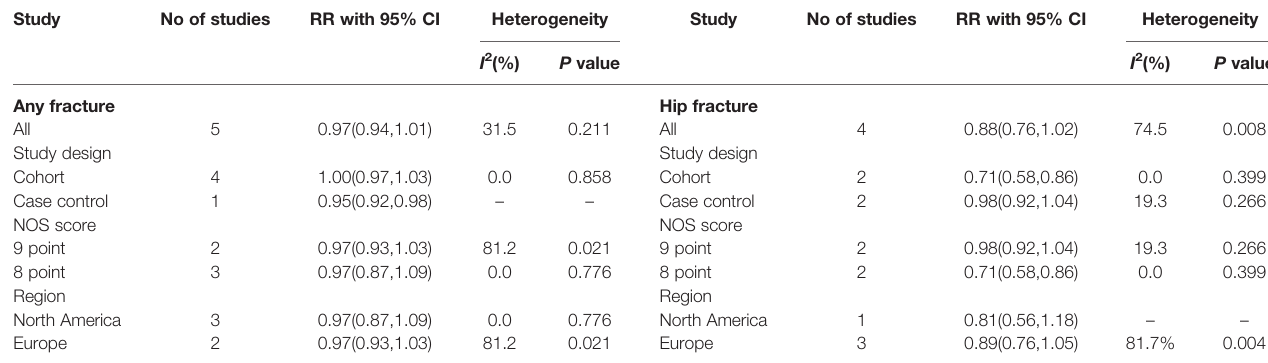
TABLE 4 | Subgroup analysis of nitrates use and fracture